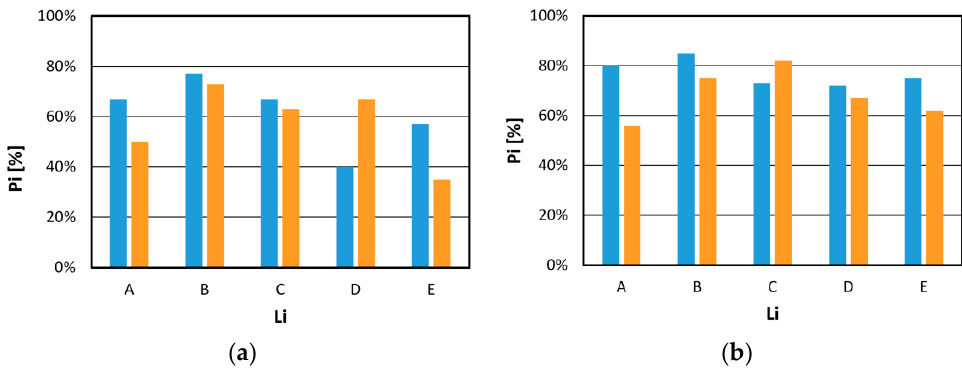
Figure 6. Percentage Pi of the number of characteristic frequencies occurring in FFT spectrum every 50 Hz in the range from 0 Hz to 3 kHz, for which the value of the given signal component in the middle point is greater than the value obtained above (blue bars) and bellow (orange bars) this point depending on the sensor location Li (according to Figure 3a): ( a ) For transformer No. 4 (25 MVA); ( b ) For transformer No. 8 (16 MVA).